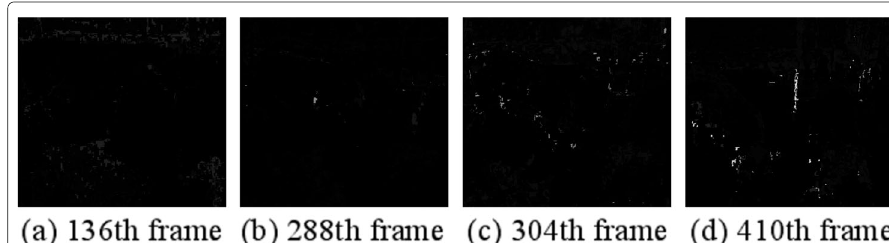
Fig. 5 Probability projection graph of multi-feature fusion